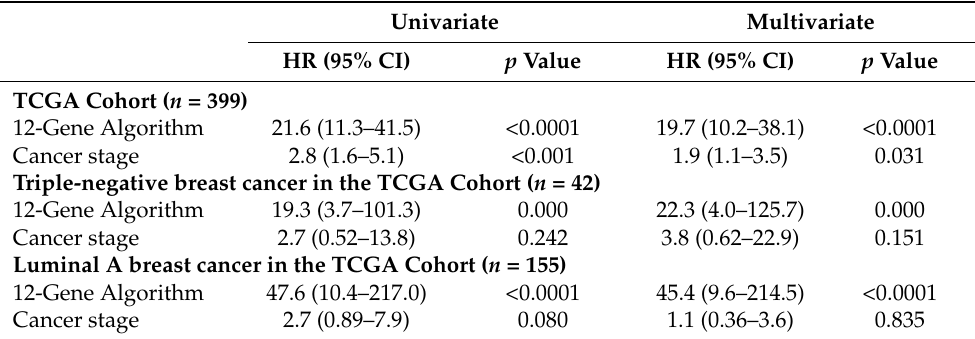
Table 3. Univariate and multivariate Cox regression analyses of the 12-Gene Algorithm and cancer stage for predicting cancer progression after treatment in the TCGA Cohort ( n = 399), triple-negative subgroup ( n = 42), and luminal A subgroup ( n =